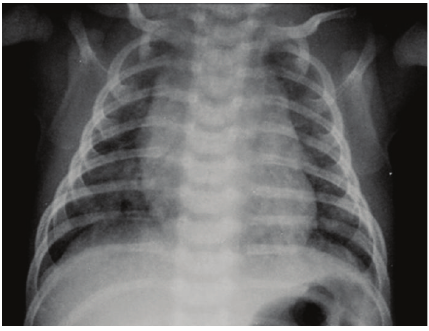
Figure 2: Hyperinflation pattern-chest radiograph showing pul- monary bilateral